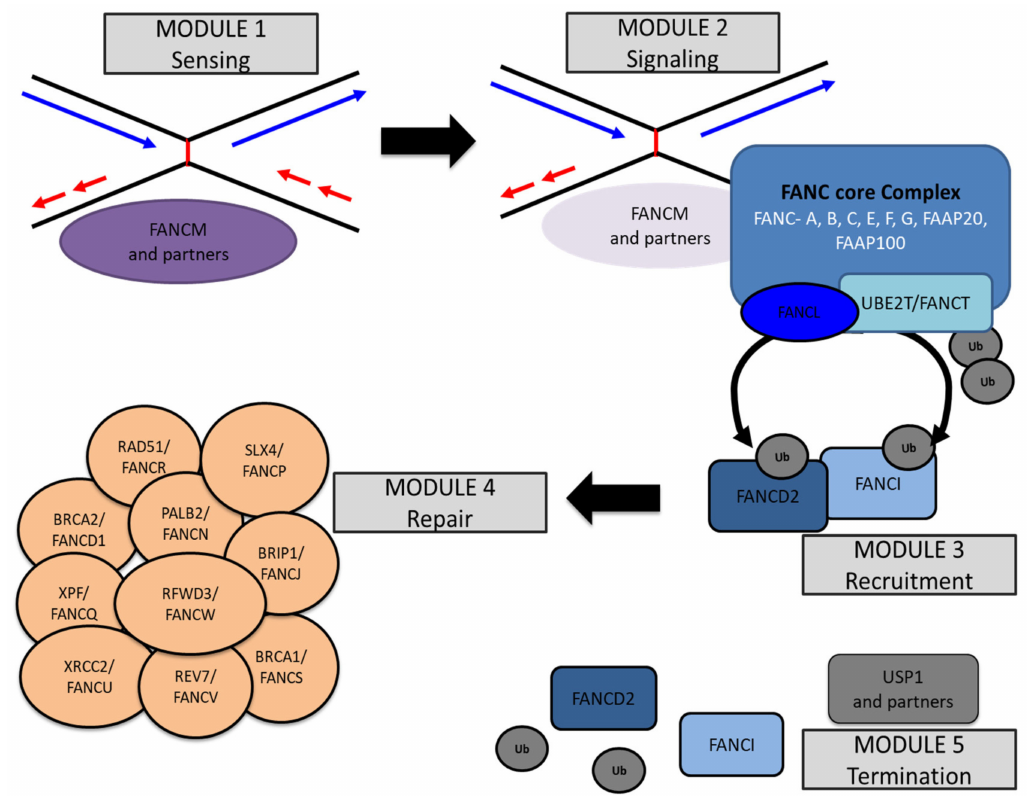
Figure 2. Fanconi anemia / breast cancer-associated (FANC / BRCA) pathway in five modules. Module 1 is composed of the FANCM protein and its partners. FANCM acts as both a translocase and a cargo protein and binds DNA in close proximity to the lesion. Then, module 1 recruits module 2, which is composed of the FANC core complex proteins (names indicated in white) and the E2-ubiquitin ligase UBE2T. The FANC core complex is an E3-ubiquitin ligase, of which FANCL is the catalytic subunit. In response to an DNA interstrand cross-link (ICL), FANCL transfers a ubiquitin moiety from UBE2T onto module 3 proteins (FANCD2 and FANCI). In turn, monoubiquitinated FANCD2 and FANCI, among others, coordinate the recruitment of the proteins of Module 4 to perform ICL removal and restart replication. Once the repair is terminated, module 5 (USP1 and its partners) terminates the reaction by deubiquitinating FANCD2 and